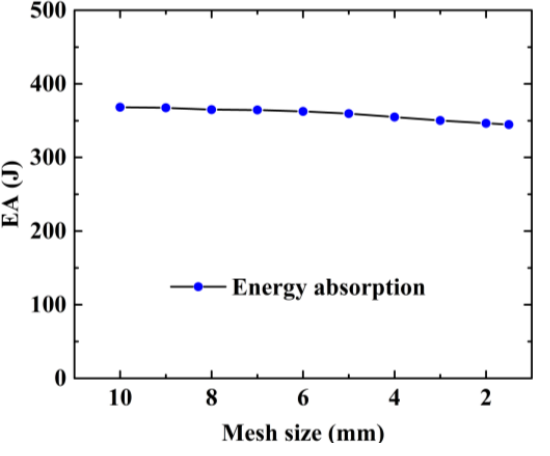
( b ) Figure 10. Comparison of load – displacement relation for foam-filled thin-walled tubes: ( a ) FUT and ( b ) FLNT-2. Table 7. Error analysis of energy absorption between FE solutions and experiment. Model